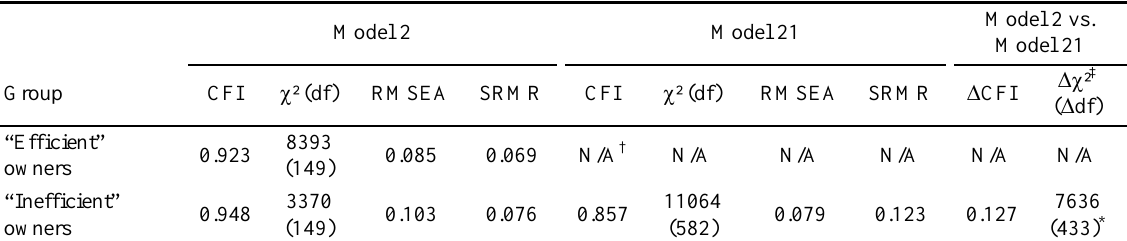
Table 1. Goodnes-of-fit statistics of the model of forest owner representations of forest management (model 2) for efficient (n = 651) and inefficient (n = 103) owners, and the model of association between the representation of forest management and cutting constraints (model 21). CFI = comparative fit index; RMSEA = root mean-squared error of approximation; SRMR = standardized root mean-square residual.